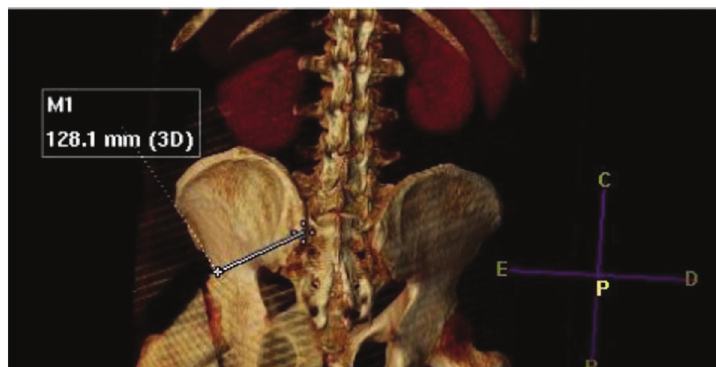
Figure 2 - Example of iliac screw length measurement (shown by white line).